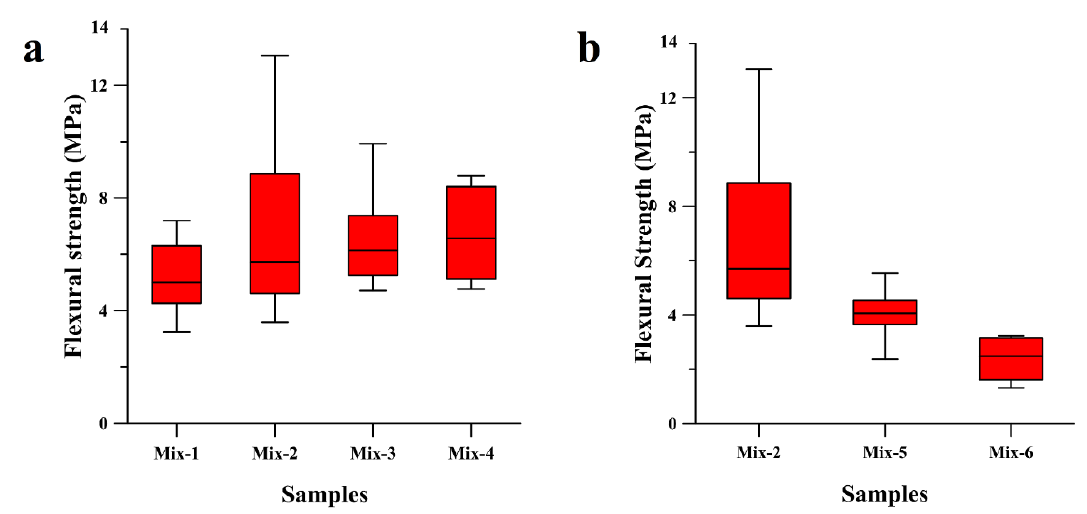
Figure 1. Comparative study of the flexural strength of geopolymer samples in terms of ( a ) silica-to- alumina ratio of the mixtures from Mix-1 to Mix-4 (2.7, 3.3, 4.2, 5.0 respectively) and ( b ) molarity of